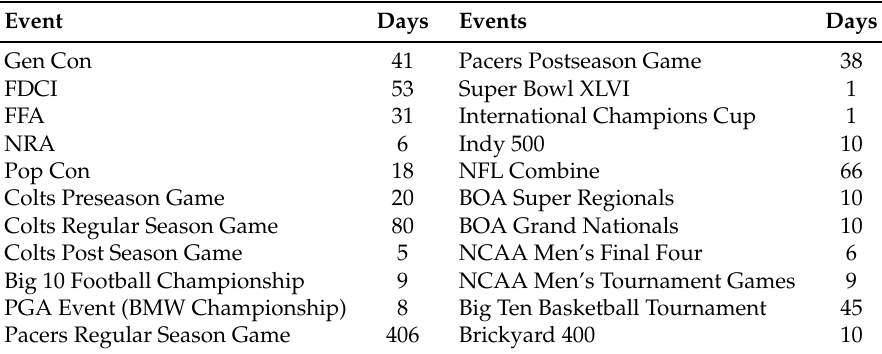
Table 1. Events in the sample along with frequency.